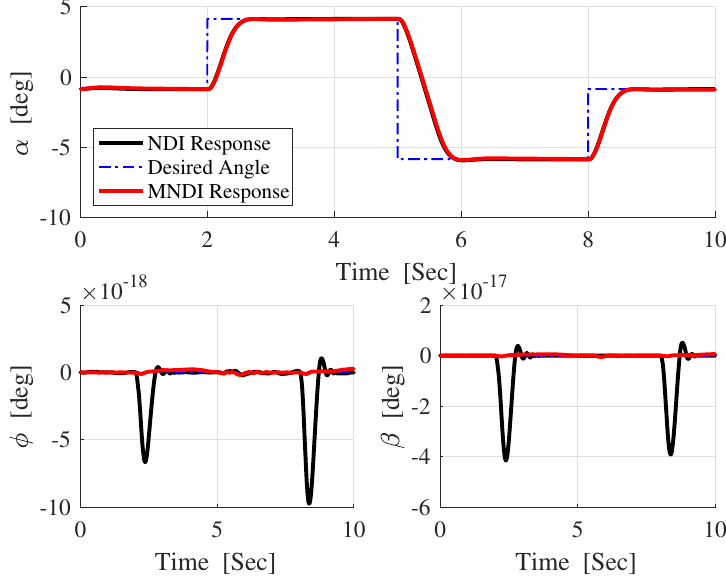
Figure 6. Attitudes response with NLDI and MNLDI with pitch angle excitation without